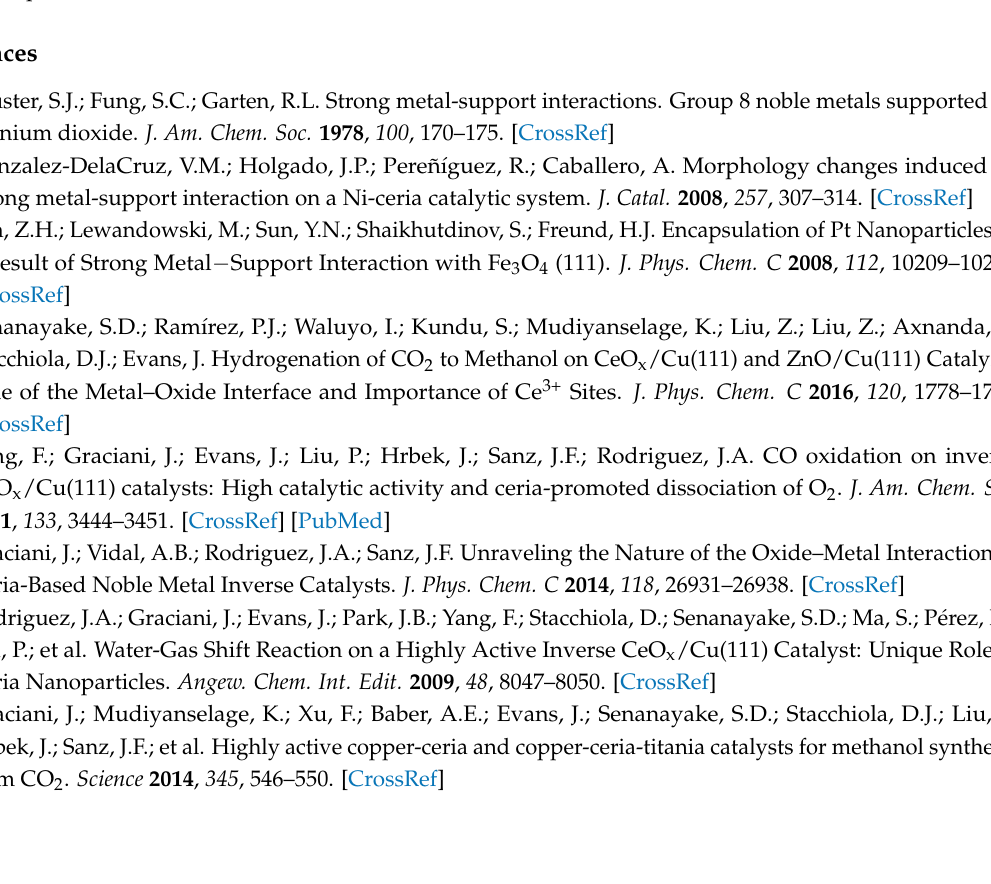
Figure S1: Gradient isosurfaces for CHO/*. The surfaces are colored on a blue-green-red scale according to values of sign( λ 2 )/ (cid:36) , ranging from − 0.05 to 0.05 au. Blue indicates strong attractive interactions, green indicates Van Der Waals interactions and red indicates strong nonbonded overlap. Table S1: Free energy (kJ/mol) for all intermediates at different temperature (K). Cartesian coordinate for all stationary points involved in this